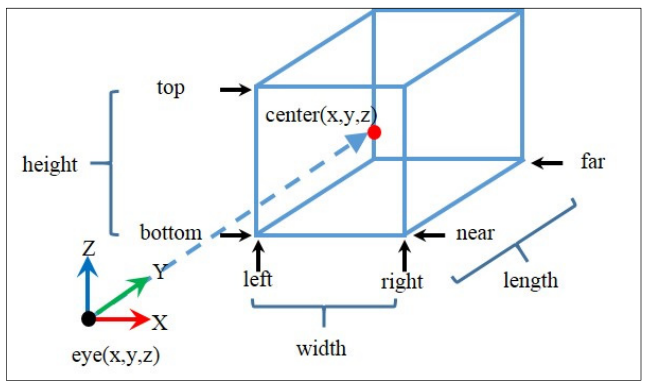
Figure 4. The view and projection transformations of an orthographic camera.